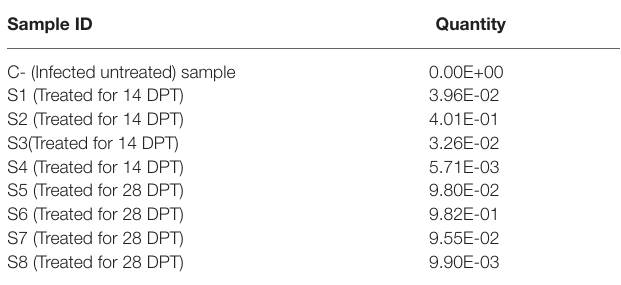
TABLE 5 | The variable change in the Toxoplasma gondii load after treatment with the anticancer in comparison with the infected, non-treated animals. Sample ID Quantity C- (Infected untreated)